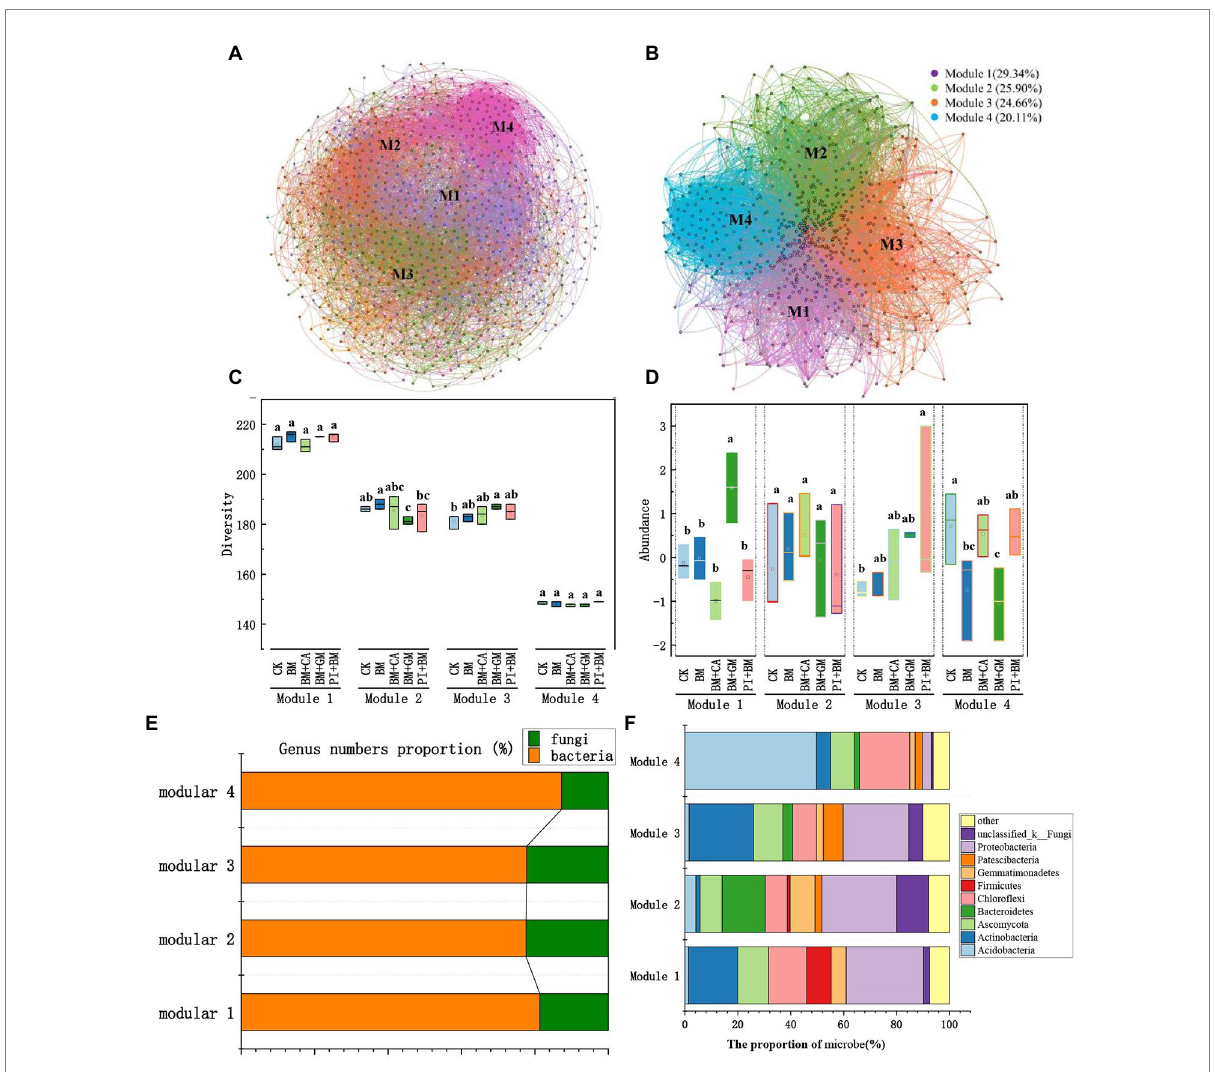
FIGURE 4 Keystone microbial taxa. (A) Network map of bacterial and fungal genera; microbial kingdoms in the network are indicated by the colors of the node. (B) Network map of microbial taxa from modules 1–4; modules in the network are indicated by different colors. (C) Microbial diversity in modules 1–4. (D) Microbial abundance in modules 1–4; the data were zero-mean normalized. (E,F) Composition of microbes in modules 1–4. CK ， BM ， BM + CA ， BM + GM ， BM + PI represent S . nigrum , Bacillus megaterium , and Bacillus megaterium along with citric acid, Glomus mosseae , and Piriformospora indica , respectively. The error bars show the standard deviation in triplicate samples, and values with different letters significantly differ according to one-way ANOVA followed by Duncan’s